Question: According to the figure, is the described quantity increasing or decreasing?
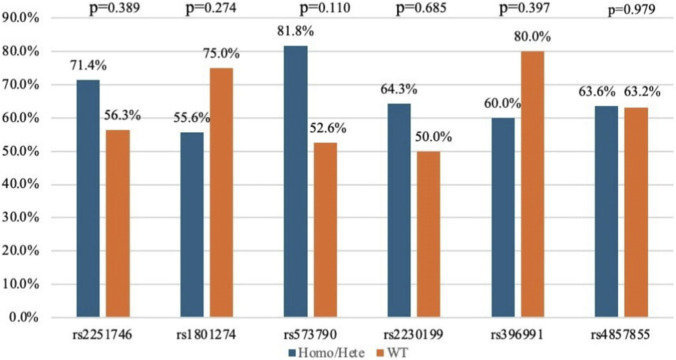
Answer: increasing